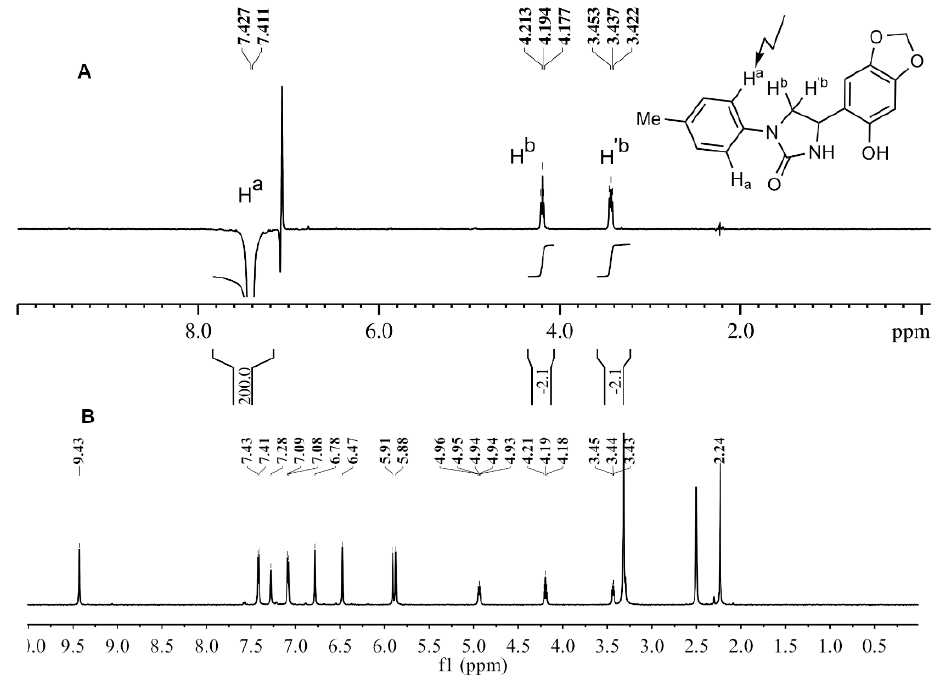
Figure 3. ( A ) 1D NOESY spectrum of compound 2c (irradiation of ortho -aromatic protons resonance) 1 H NMR spectrum of compound 2c (400 MHz, (CD (500 MHz, (CD 3 ) 2 SO, 303 K); ( B ) 1 H NMR spectrum of compound 2c (400 MHz, (CD 3 ) 2 SO, 303 K). (500 MHz, (CD 3 ) 2 SO, 303 K); ( B )